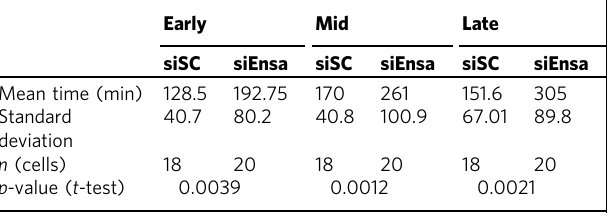
Table 1 Spatiotemporal patterns of replication of Ensa KD